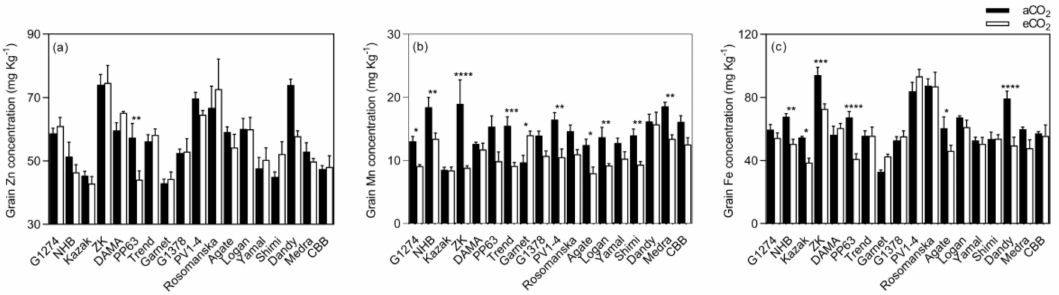
Figure 4. Grain micronutrient ( a – c ) concentrations of bean grown under aCO 2 (400 ppm) and eCO 2 (800 ppm). Each bar represents the mean ± SE ( n = 10 plants). * p < 0.05; ** p < 0.01; *** p < 0.001; **** p < 0.0001 significance